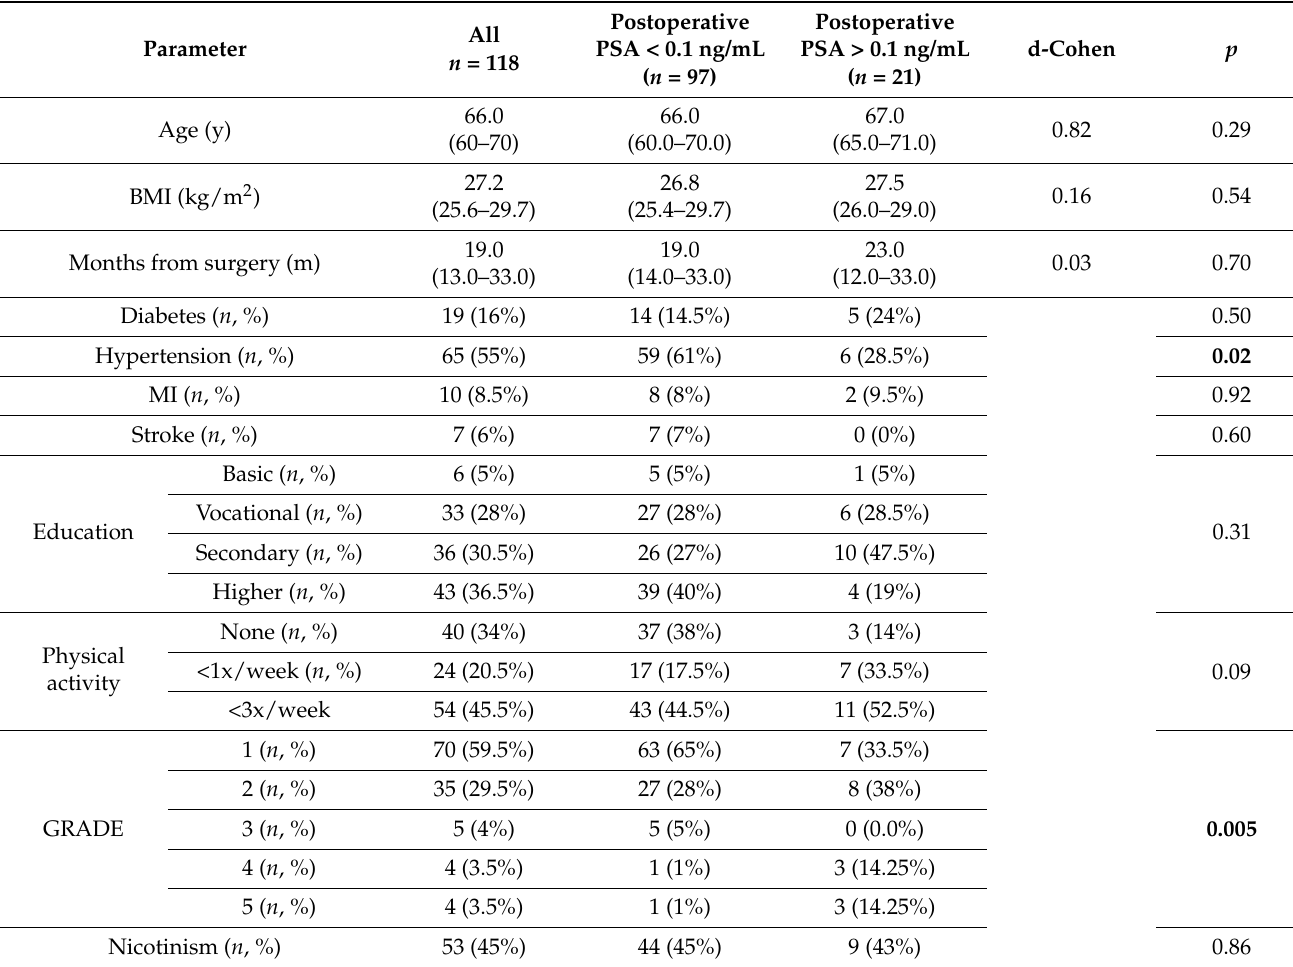
Table 2. Demographic and clinical data in all group and in subgroups with and without persistently elevated PSA levels.